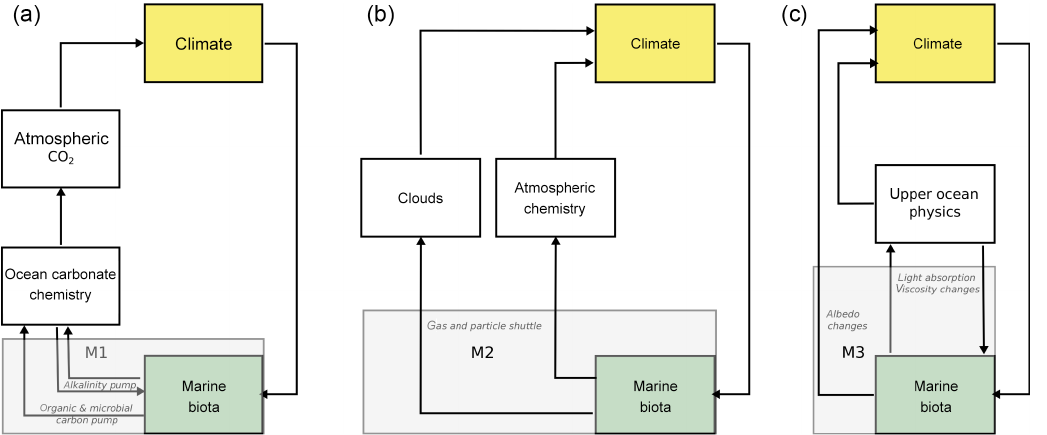
Figure 1. Major global climate feedback loops, based on the three classes of mechanisms (light grey-shaded boxes), driven by marine biota (green-shaded boxes). Only links originating from the marine biota are shown; additional inter- and cross-links between the different boxes are omitted for clarity. (a) The three mechanisms (the organic and the microbial carbon pump, and the alkalinity pump) affect the CO 2 inventory in the ocean, which in turn leads to changes in atmospheric CO 2 and thus in climate. An altered global climate influences the marine biota (through, for example, changes in SST, near-surface stratification, and circulation patterns), closing the marine part of the climate–carbon cycle feedback loop which also includes the CO 2 calcification feedback. (b) The gas and particle shuttle alters cloud formation rates and distribution as well as atmospheric chemistry. There is a complex interplay between different atmospheric components that ultimately lead to climate change, again with consequences for the marine biota. A number of atmospheric feedbacks (e.g., the cloud– albedo feedback, the long-wave radiation feedback, the chemistry feedbacks) are involved in this loop. Note that the influence of marine biota on local cloud cover is not illustrated here. (c) Two biogeophysical mechanisms (based on light absorption and turbulent viscosity changes) directly affect the upper ocean physics such as heat distribution and circulation and hence the biota. The third one (albedo changes) has a direct effect on the planetary radiation budget, which influences in turn the marine